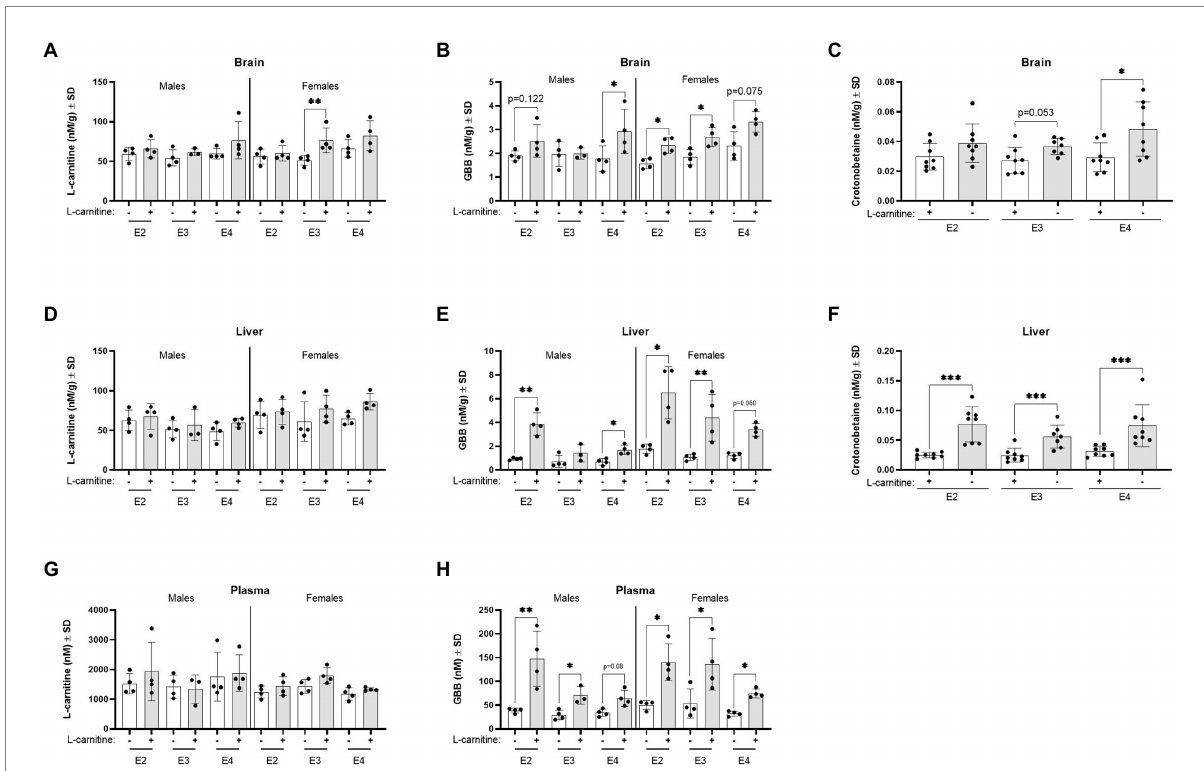
FIGURE 8 L-carnitine metabolites are affected by sex and APOE after an oral L-carnitine challenge. (A) Scatterplots with bar showing mean concentration of L-carnitine in nM per gram of protein ± SD in the brain of vehicle and L-carnitine challenged mice with sex and APOE genotype. (B) Scatterplots with bar showing mean concentration of GBB in nM per gram of protein ± SD in the brain of vehicle and L-carnitine challenged mice with sex and APOE genotype. (C) Scatterplots with bar showing mean concentration of crotonobetaine in nM per gram of protein ± SD in the brain of vehicle and L-carnitine challenged mice in different APOE genotypes. (D) Scatterplots with bar showing mean concentration of L-carnitine in nM per gram of protein ± SD in the liver of vehicle and L-carnitine challenged mice with sex and APOE genotype. (E) Scatterplots with bar showing mean concentration of GBB in nM per gram of protein ± SD in the liver of vehicle and L-carnitine challenged mice with sex and APOE genotype. (F) Scatterplots with bar showing mean concentration of crotonobetaine in nM per gram of protein ± SD in the liver of vehicle and L-carnitine challenged in different APOE genotypes. (G) Scatterplots with bar showing mean concentration of L-carnitine in nM ± SD in plasma in vehicle and L-carnitine challenged mice with sex and APOE genotype. (H) Scatterplots with bar showing mean concentration of GBB in nM ± SD in plasma in vehicle and L-carnitine challenged mice with sex and APOE genotype. Statistics: multiple comparisons with B-H correction, * p < 0.05, ** p < 0.01, *** p < 0.001. Numbers per group: male E2 (vehicle) n = 4, male E2 (L-carnitine) n = 4, male E3 (vehicle) n = 4, male E3 (L-carnitine) n = 3, male E4 (vehicle) n = 4, male E4 (L-carnitine) n = 4, female E2 (vehicle) n = 4, female E2 (L-carnitine) n = 4, female E3 (vehicle) n = 4, female E3 (L-carnitine) n = 4, female E4 (vehicle) n = 4, female E4 (L-carnitine) n = 4, E2/E2 (vehicle) n = 8, E2/E2 (L-carnitine) n = 8, E3/E3 (vehicle) n = 8, E3/E3 (L-carnitine) n = 7, E4/ E4 (vehicle) n = 8, E4/E4 (L-carnitine) n = 8. GBB, γ -butyrobetaine. Crotonobetaine not detected in